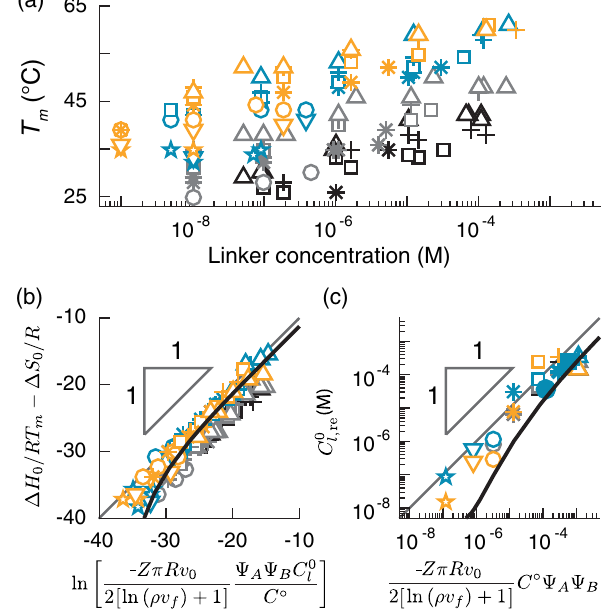
FIG. 5. Melting temperatures and reentrant concentrations collapse onto master curves. (a) shows roughly 200 measure- ments of the melting temperature (points) for different combi- nations of linker concentration, linker length, and grafting density. Color indicates linker length: 17 nt (black), 19 nt (gray), 21 nt (blue), and 23 nt (orange). Symbols indicate grafting density: 2000 (upward triangle), 1000 (plus), 500 (square), 200 (asterisk), 100 (circle), 50 (downward triangle), and 20 (star) DNA strands per μ m 2 . (b) The same data collapse when rescaled according to Eq. (1). (c) The measured reentrant concentrations collapse and exhibit a power-law dependence on the grafting density Ψ , as given by Eq. (2). Filled symbols correspond to unequal grafting densities. The solid black curves in (b),(c) show predictions of the full theory. The black curve in (b) is generated by rescaling the full-theory predictions at intermediate concen- trations below C 0 l; re